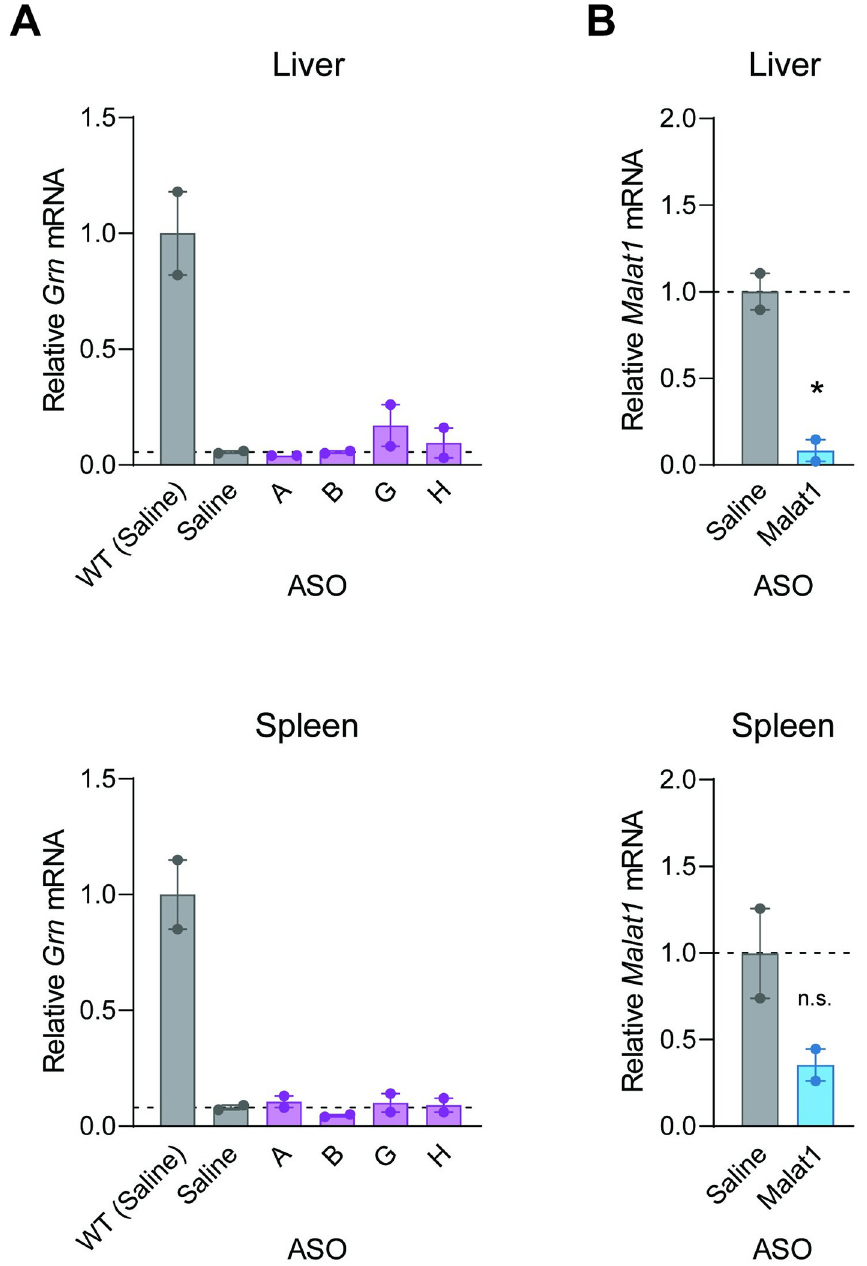
Fig 2. IP administration of ASOs targeting NMD of the Grn R493X mRNA does not increase Grn mRNA levels in the livers and spleens. qPCR results from livers and spleens of Grn R493X/R493X mice following a series of four IP administrations of 50 mg/kg ASO. (A) Grn mRNA levels are presented relative to levels in tissues of wild-type mice that received control ASO. (B) Malat1 mRNA levels in wild-type mice. Data are presented as means ± SEM; � indicates p < 0.05, as determined by one-way ANOVA with Tukey post hoc test in (A) and by t-test in (B). n.s., not significant. levels in vivo . To rule out delivery issues, we used a validated Malat1 -targeting ASO as a posi- tive control and observed the expected effect of lowering Malat1 mRNA levels. We also con- firmed broad ASO distribution in the brain by immunostaining. Lastly, after completion of